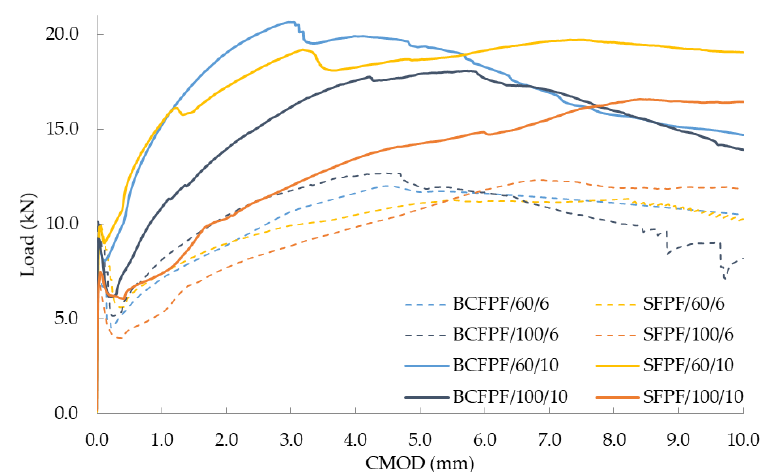
Figure 8. Load—CMOD (crack mouth opening displacement) relationship graphs for 450/0.8 matrix after 28 days of curing.